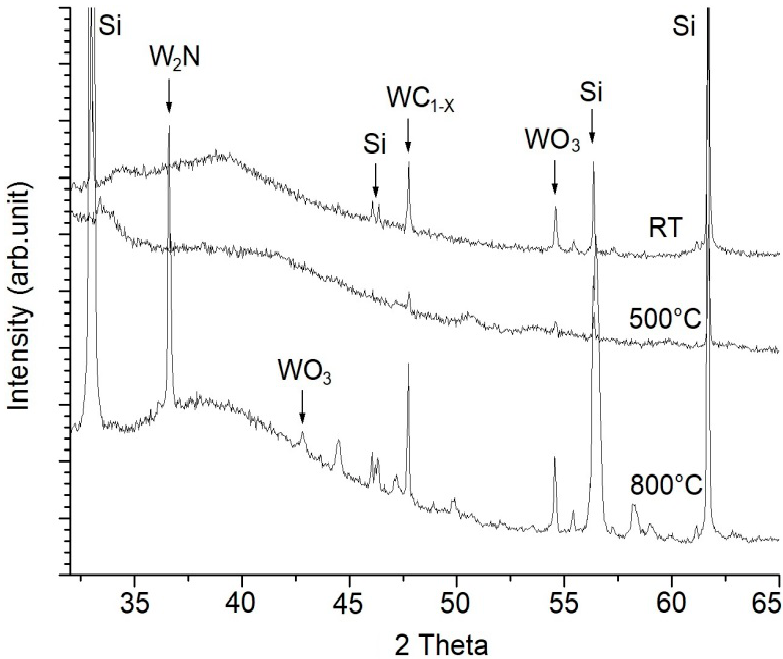
Figure 7. X-ray diffraction spectra of WC/C coatings at RT, after annealing at 500 and 800 °C; Si phase.